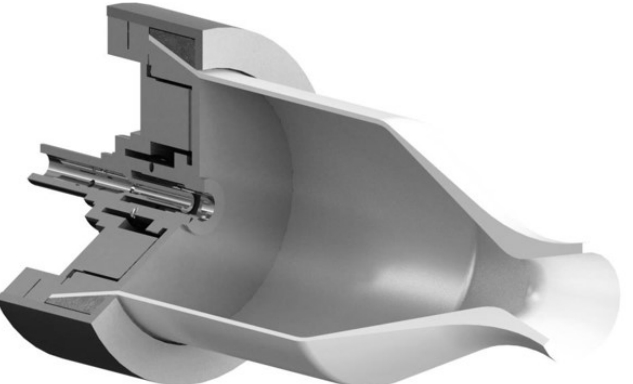
Figure 32. Revised engine design for a pure OCMC combustion chamber with